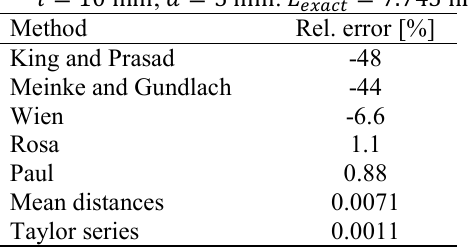
Table 5: Errors of the various methods